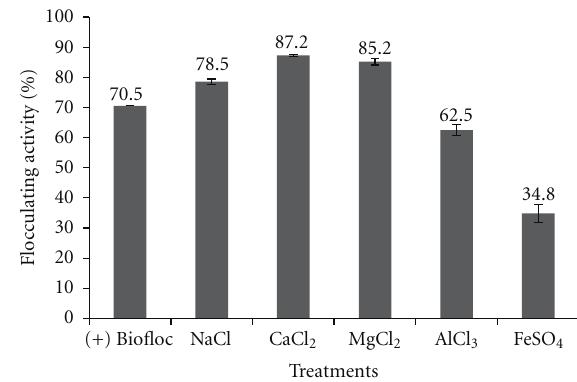
Figure 1: The e ff ect of monovalent, divalent, and trivalent cations on the flocculating activity of bioflocculant produced by Bacillus spp . UPMB13. (+) Biofloc treatment act as control for comparison with the other cation